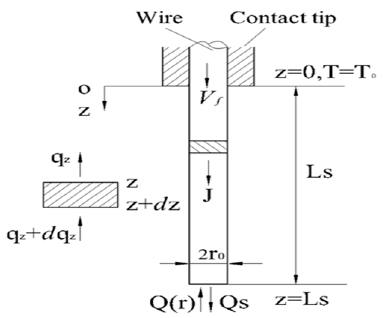
Figure 6. Modeling of stickout temperature field.